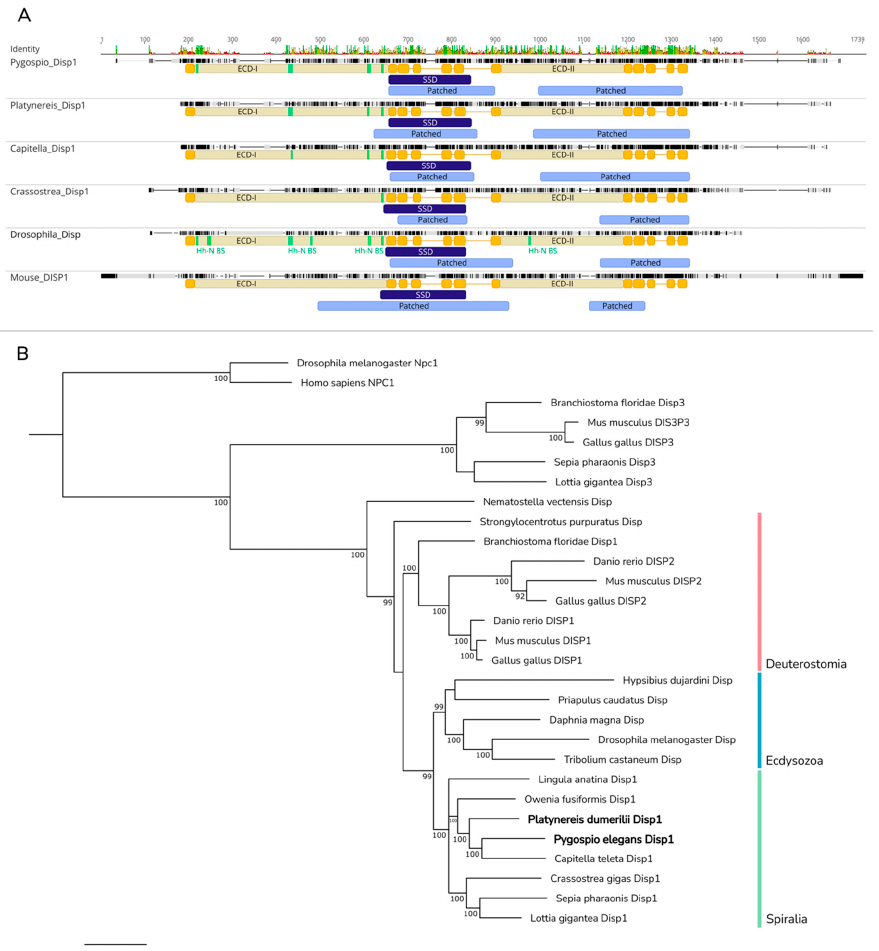
Figure 4. Multiple sequence alignment and phylogenetic analysis of Disp proteins. ( A ) Pdum-Disp1 and Pele-Disp1 share a similar structure with Ptc proteins, comprising 12 transmembrane helices, 2 extracellular domains (ECDs), and conserved Patched domains. As in Ptc, TMs 2–6 form a sterol-sensing domain. Fifteen amino acid residues of Drosophila Disp ECDs are involved in Hh-N ligand binding (indicated by green bars). Of these, only relatively few residues are conserved between fruit fly and spiralians (indicated by green bars). Patched, Patched domain (Pfam: PF02460); ECD-I and ECD-II, extracellular domains; TM, transmembrane domain; SSD, sterol-sensing domain; Hh-N BS, Hh-N-binding site. ( B ) Analysis was performed on amino acid sequences localized between terminal transmembrane helices. Pele-Disp1 and Capitella Disp formed a sister clade to Pdum-Disp1, and Owenia Disp was a basal annelid branch. Putative orthologs of Disp3 proteins were not found in the examined Platynereis and Pygospio transcriptomes. Numbers near branch nodes indicate Bayesian posterior probabilities. Bayesian posterior probability values less than 75 are not